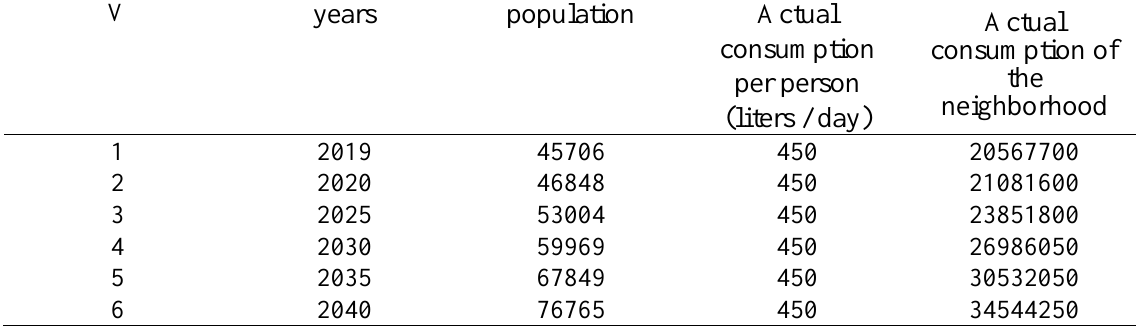
Table 9. Predicting the rate of daily water consumption / Milad district / source: the researcher. V